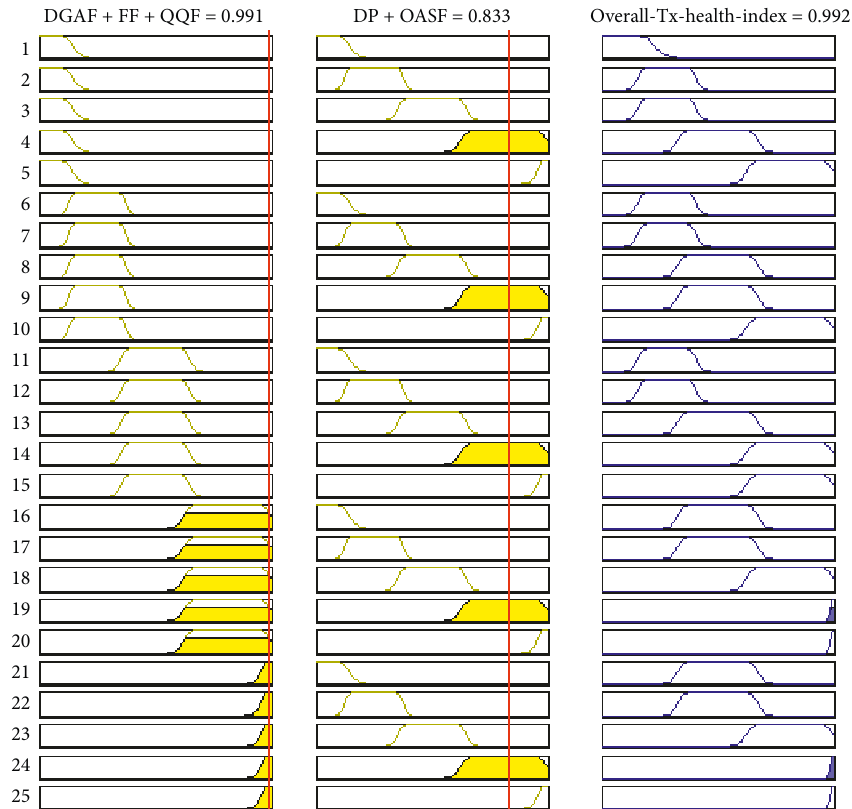
Figure 12: Rules for the developed fuzzy logic-based transformer health index